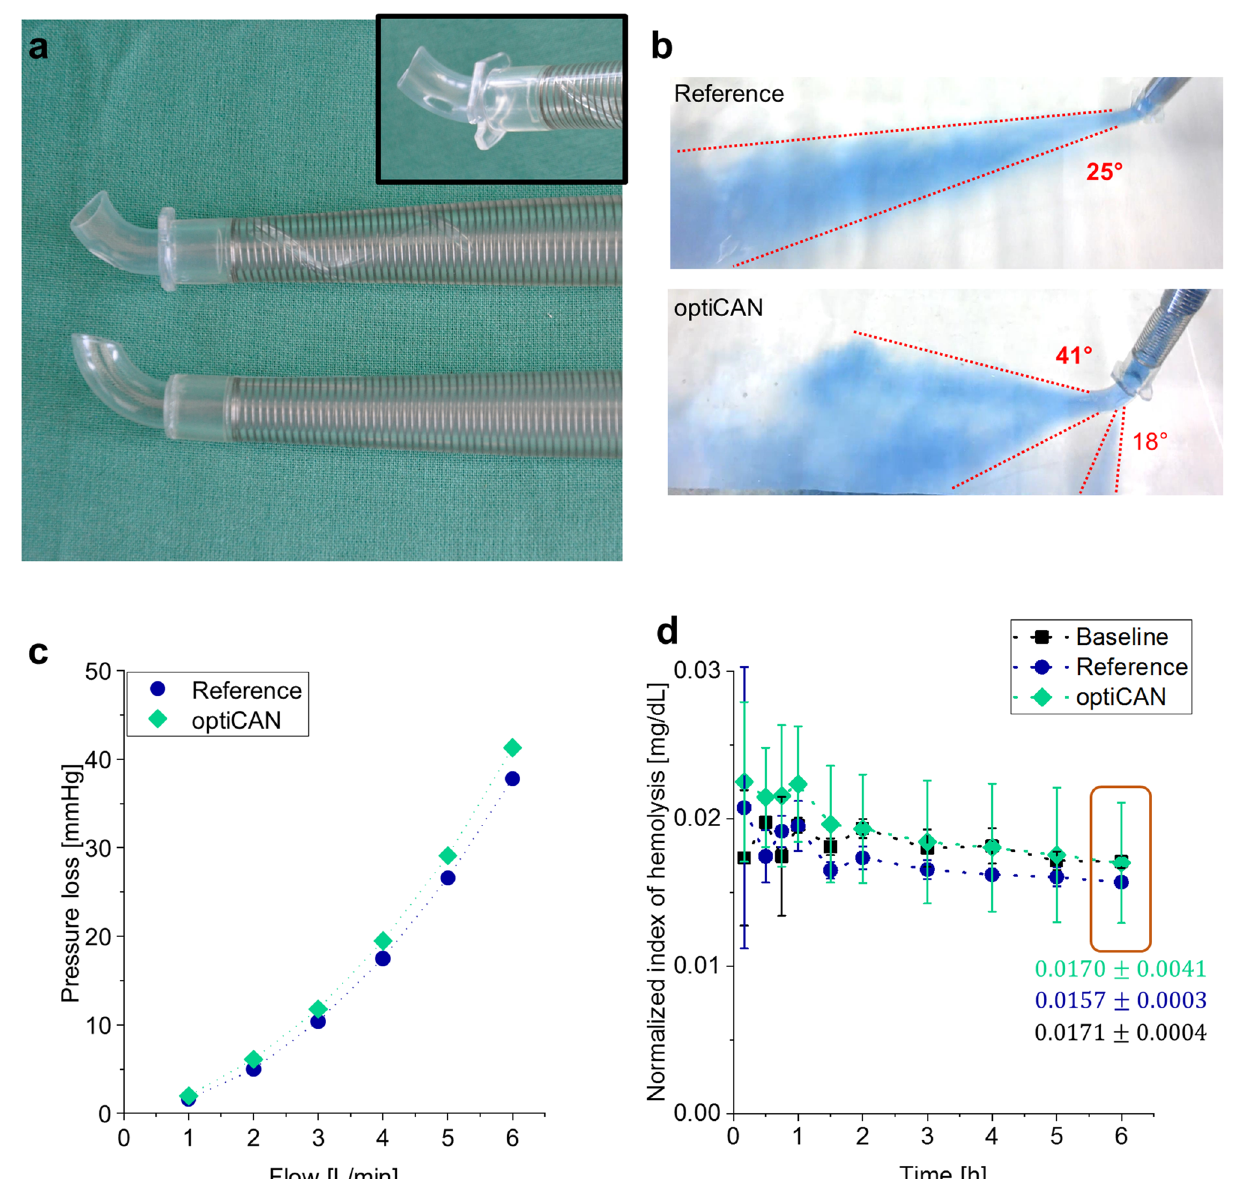
Figure 1. In vitro testing results comparing optiCAN to reference. ( a ) Photography of optiCAN design (upper cannula) in comparison to common reference cannula (lower cannula); both 24 Fr. The inset highlights the optiCAN tip design with outflow side hole. ( b ) Ink-stained outflow-jet visualization at 6 L/min for optiCAN design and reference. The outflow contours are marked with red-dashed lines, which engulf the outflow angle. Note the second outflow jet for the optiCAN design at the side hole with a smaller outflow angle. ( c ) Pressure loss over cannula flow comparing optiCAN design with the reference. ( d ) Normalized index of hemolysis (NIH) measured over six hours comparing a baseline circuit without cannula, to a reference cannula and optiCAN circuits. The NIH values after 6 h are marked (orange box) and explicit values are given for